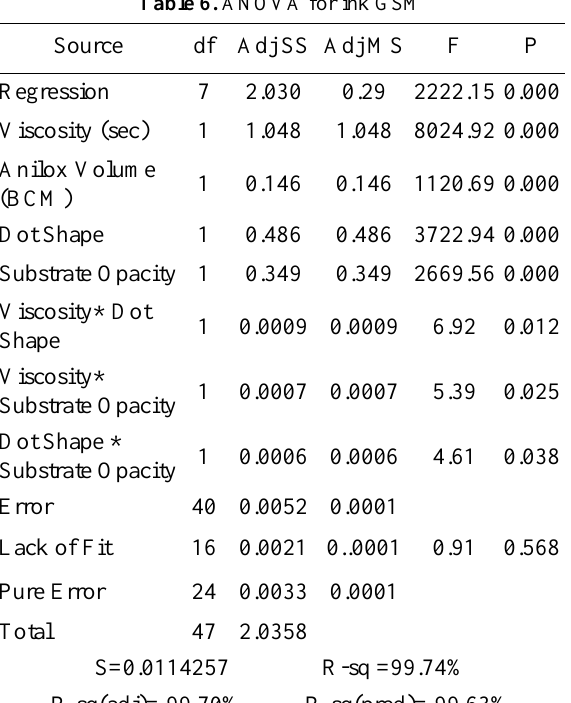
Figure 5. Interaction plot for ink GSM Table 6. ANOVA for ink